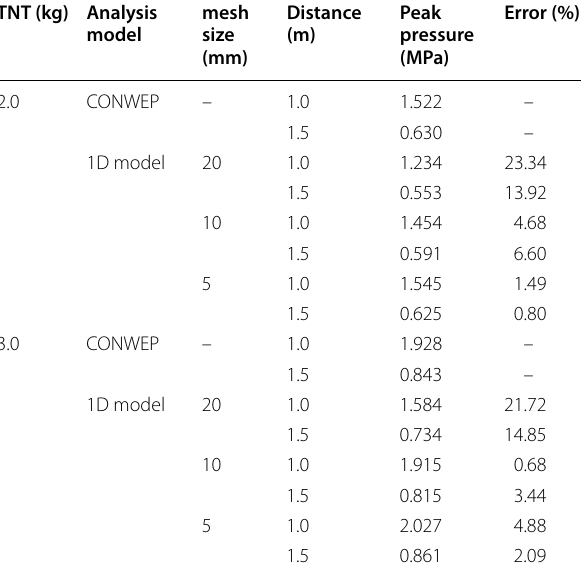
Table 2 2 kg and 3 kg TNT pressure